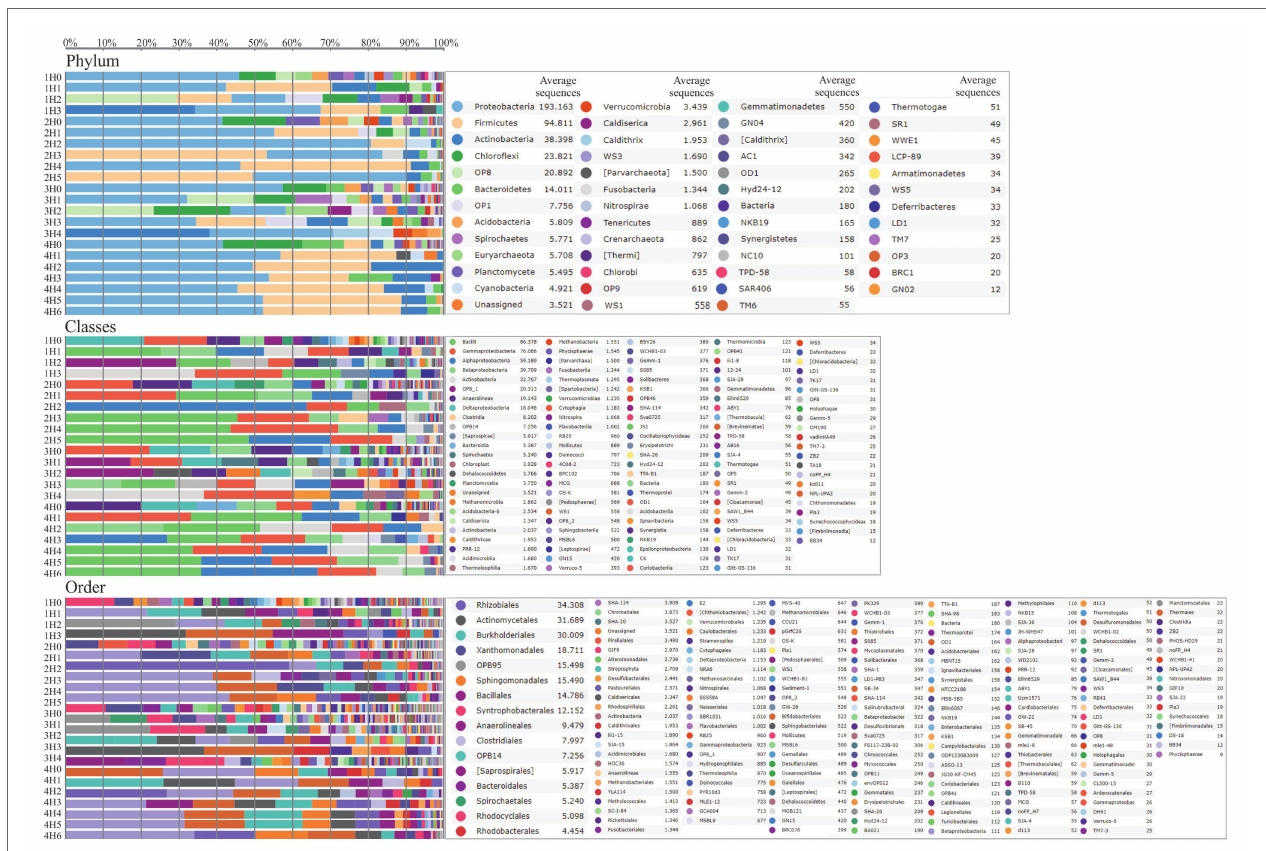
FIGURE 3 | Taxonomy assignment in the samples under study showing the Relative Abundance at the Phylum, Class, and Order